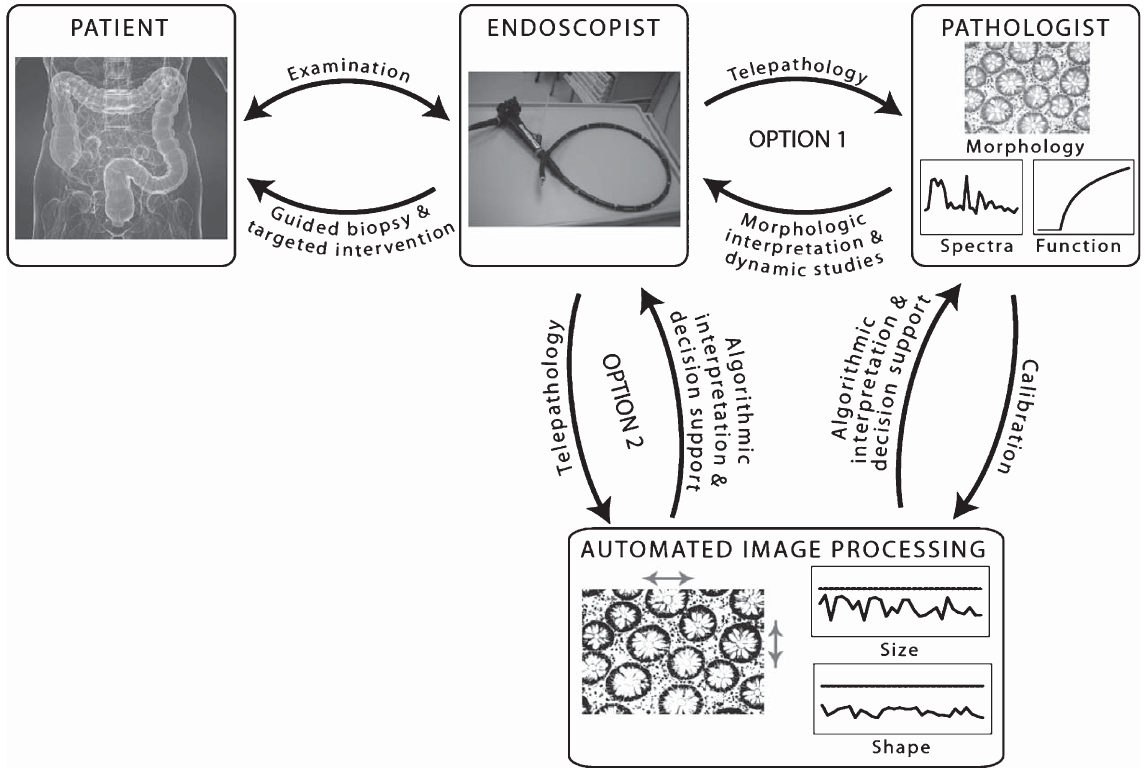
Fig. 1. An example of how point-of-care pathology, via endoscopic microscopy, may be incorporated into the clinical workflow for the detection of gastrointestinal diseases. Option 1 depicts the proceduralist and pathologist working as a team. Option 2 depicts the proceduralist working by her/himself, possibly with the aid of automated image processing tools. See text for